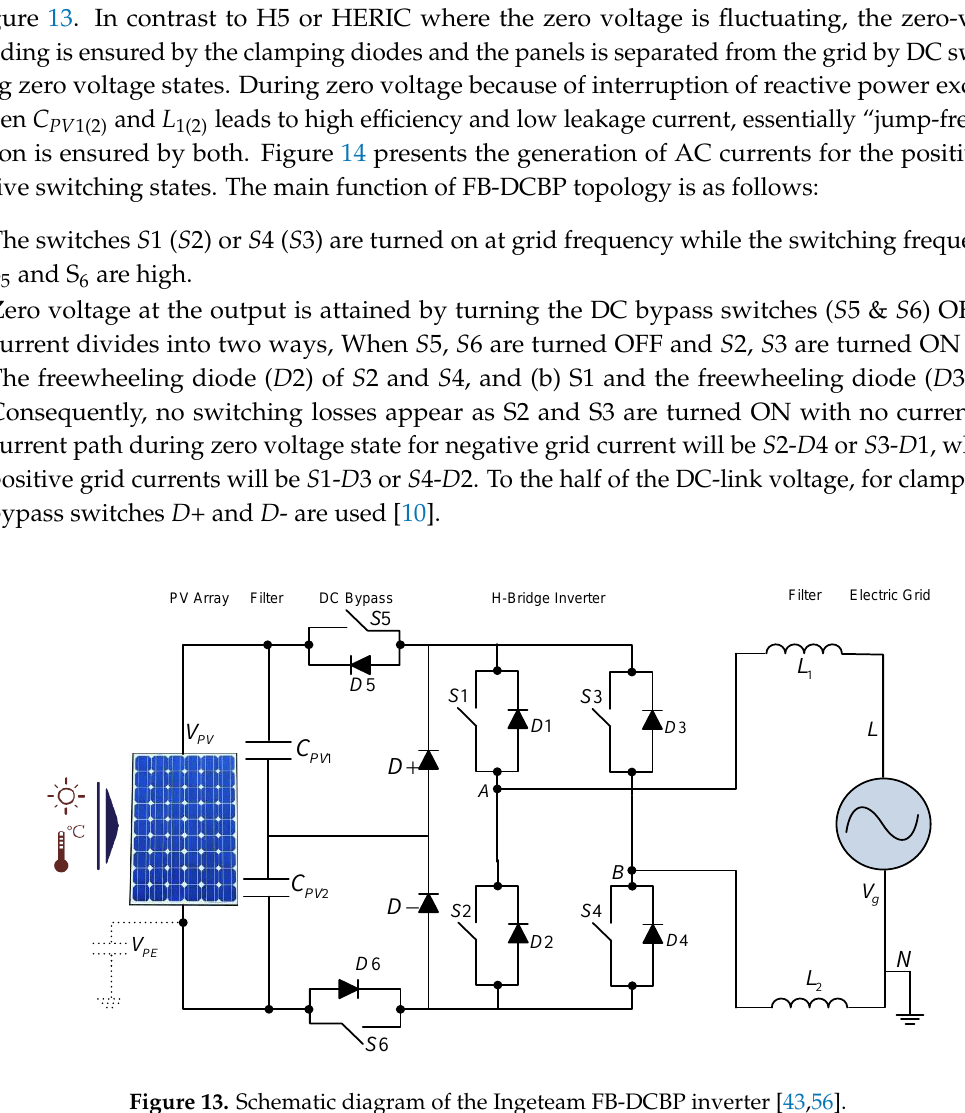
Figure 13. Schematic diagram of the Ingeteam FB-DCBP inverter [43,56].